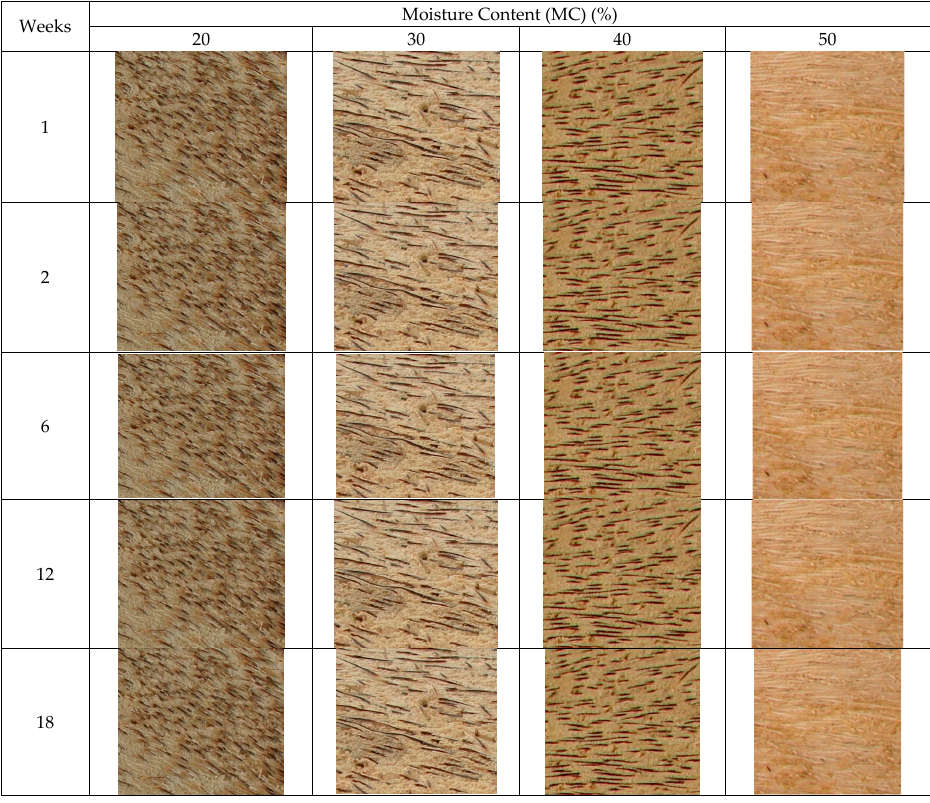
Figure 4. The surface color of oil palm samples immersed in tap water for 48 h, and thereafter im- mersed in Dursban 4E for another 48 h, after which the samples were conditioned in a kiln to vary- ing moisture contents at a thickness of 40 mm. There was no significant change in the color of the specimens during the eighteen weeks of observation. Figure 4 shows images of the original oil palm wood surfaces after they were im- mersed in tap water for 48 h, and thereafter immersed in Dursban 4E for another 48 h, after which the samples were conditioned in a kiln. It can be clearly observed that oil palm lumber surfaces were all clear, having no discoloration for all the moisture contents and at the 18-week duration. Tap water caused the disruption of sugar and starch pathways in the palm wood, which could have been the food for the discoloration fungi. This is because during the immersion of oil palm lumber, sugar and starch on the surfaces were washed quickly, and the water prevented the migration, deposition, and concentration of sugar and starch at the surface. Similar results were reported in other studies: in their study, [46] observed that water reduced surface discoloration. In contrast, discoloration was reported to be present at the wood’s surface by [47]. [48] emphasized that wood spec- imens treated with water greatly reduced the levels of fatty acids without any visual dis- coloration to the wood specimens. [49] used water to alleviate discoloration in wood. [50] highlighted that an effective method of eliminating wood biodeterioration attacks is to